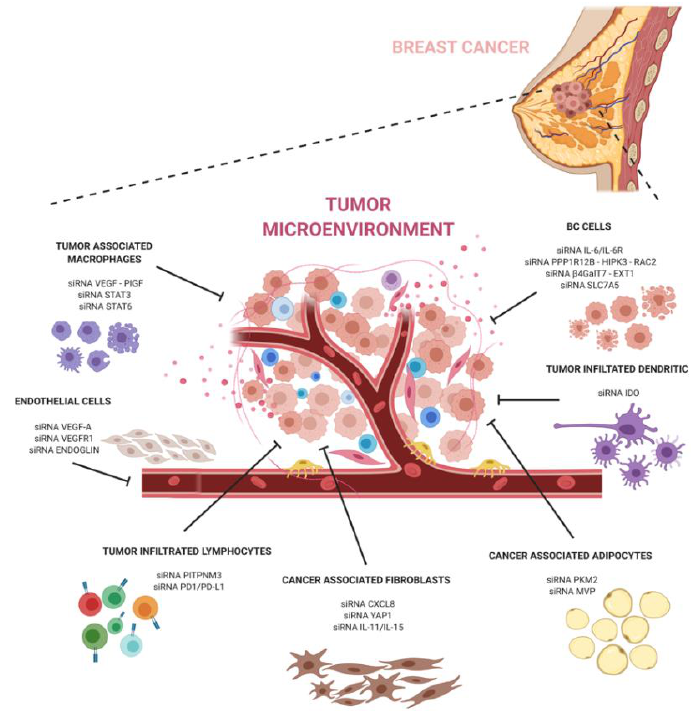
Figure 1. A schematic representation of siRNAs against major components of the breast cancer microenvironment. The image shows siRNAs and their targets described in the text .